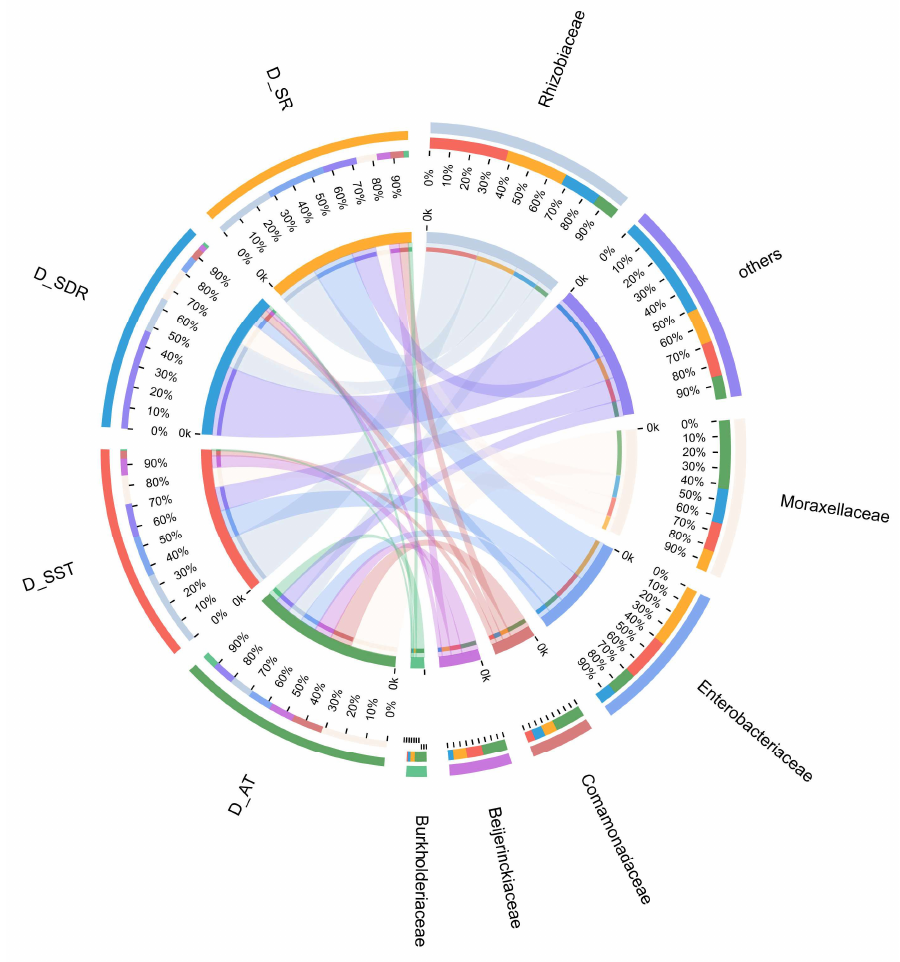
Figure 4. Circos plots exhibit the species composition of Plant D at the top 95% of family level of relative abundance in distinct treatment units. D_AT: aeration tank of Plant D; D_SST: secondary settling tank of Plant D; D_SDR: sludge dewatering room of Plant D; and D_SR: screen room of Plant D.